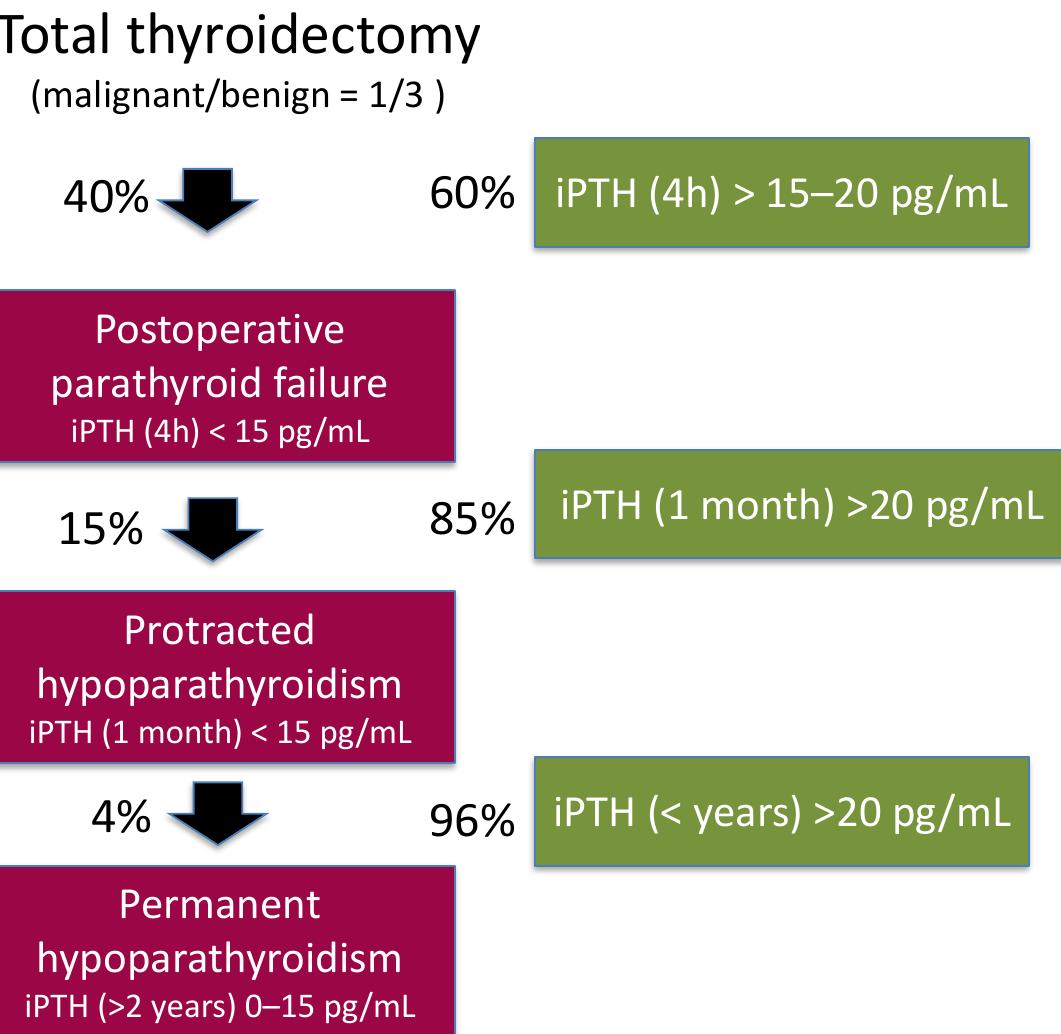
Figure 2. Hypothetical flow diagram showing the different stages of postoperative hypoparathyroidism (red pathway) or recovery of the parathyroid function (green pathway) after 100 total thyroidectomies performed in a high volume and experienced surgical unit (based on refs.